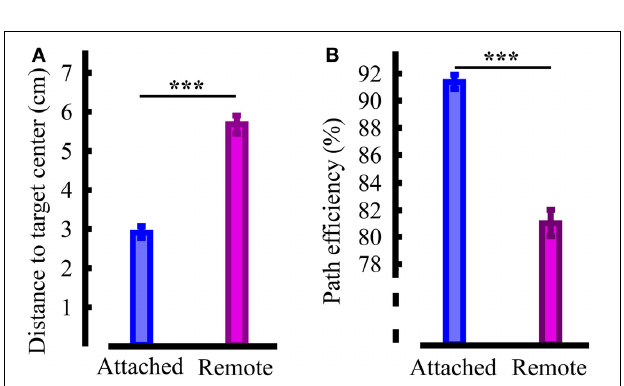
(A) KF using EMG alone and (B) the mKFT, combining the gaze from the 0.5s period before the reach initiation with EMG control; and Subject 6 with (C) KF using only the upper trapezius EMG and (D) mKFT.